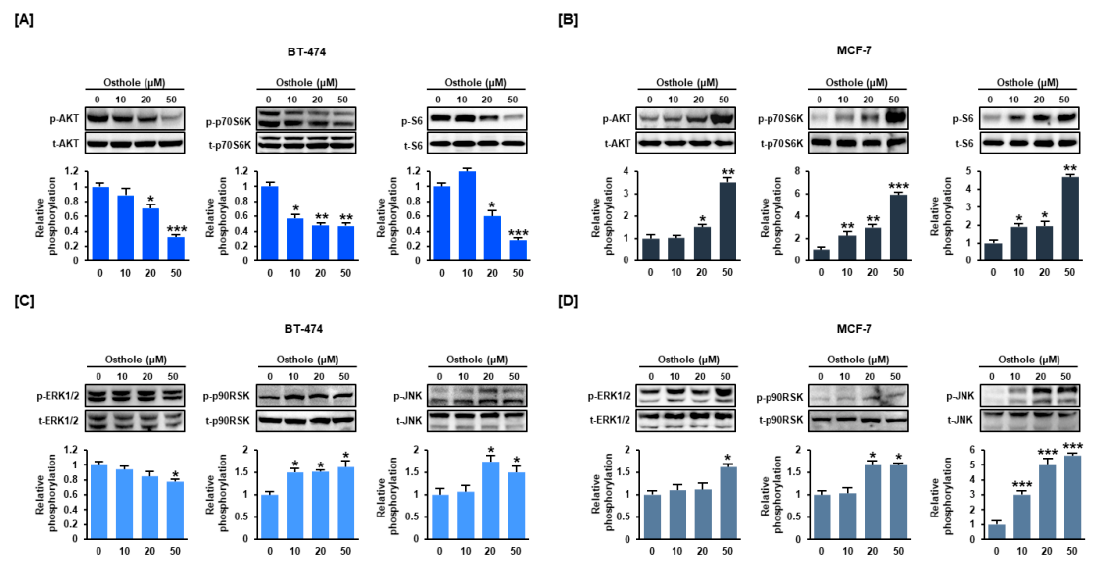
Figure 6. Effect of osthole on phosphorylation of PI3K/Akt and MAPK pathway proteins in human breast cancer cells. The levels of Akt, p70S6K, S6 ( A , B ), ERK1/2, p90RSK, and JNK ( C , D ) were detected by western blot analysis. Each phosphorylated protein was normalized to the corresponding total protein. Band intensity is shown in the graph as relative value compared to non-treated control (0 μ M). All experiments were performed in biological triplicate and the asterisks indicate statistically significant differences (* p < 0.05, ** p < 0.01 and *** p < 0.001).